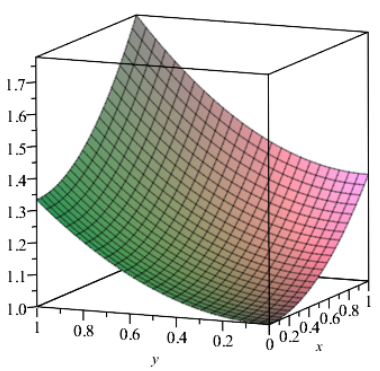
Figure 1. Illustration of Example 3: Let f ( s , t ) = H ( µ , ν ) = ( 6 + 2 µ